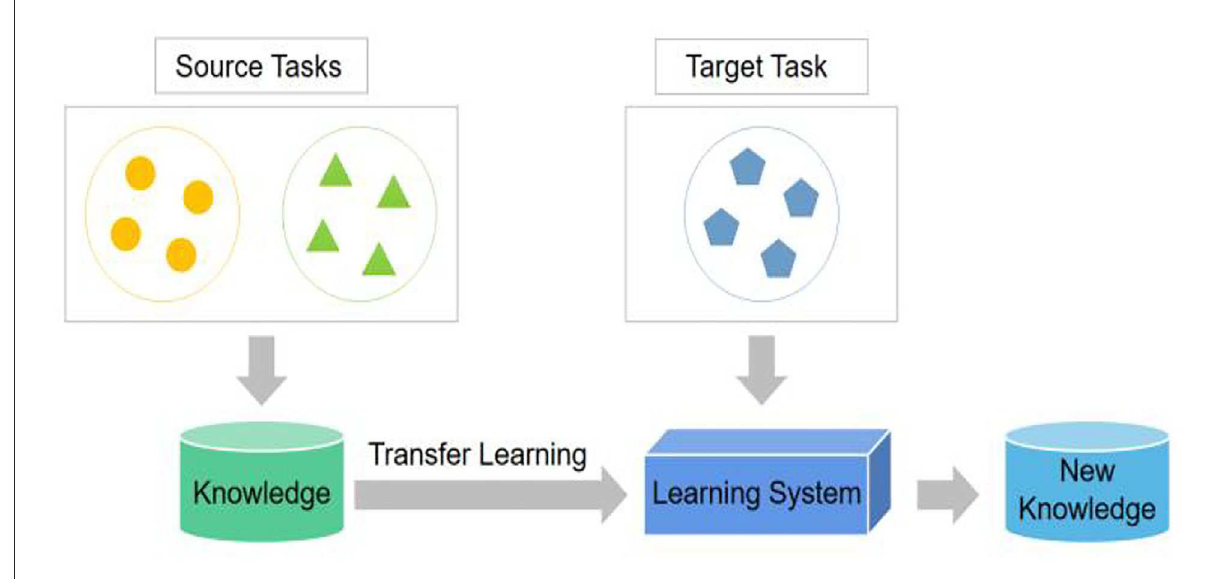
FIGURE1 Schematic of TL.